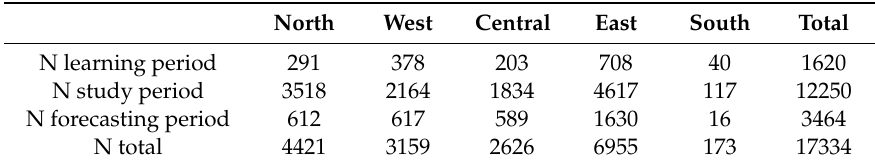
Figure 5. The five major regions of Africa: North, West, Central, East and South. Source: Wikimedia Commons, the free media repository. Table 4. Number of conflict events in each region for the learning period (2012), study period (2013–2016) and forecasting period (2017) and in total (2012–2017).